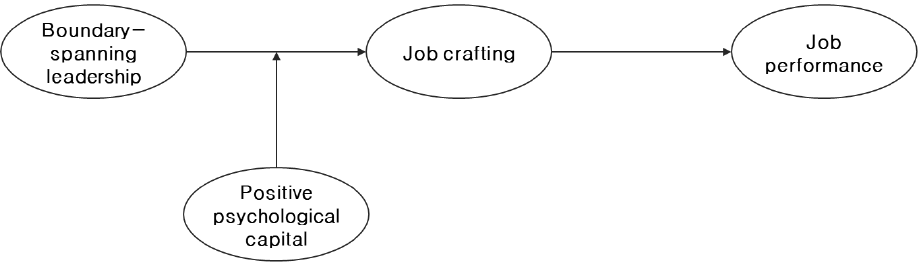
Figure 1. Conceptual research model.